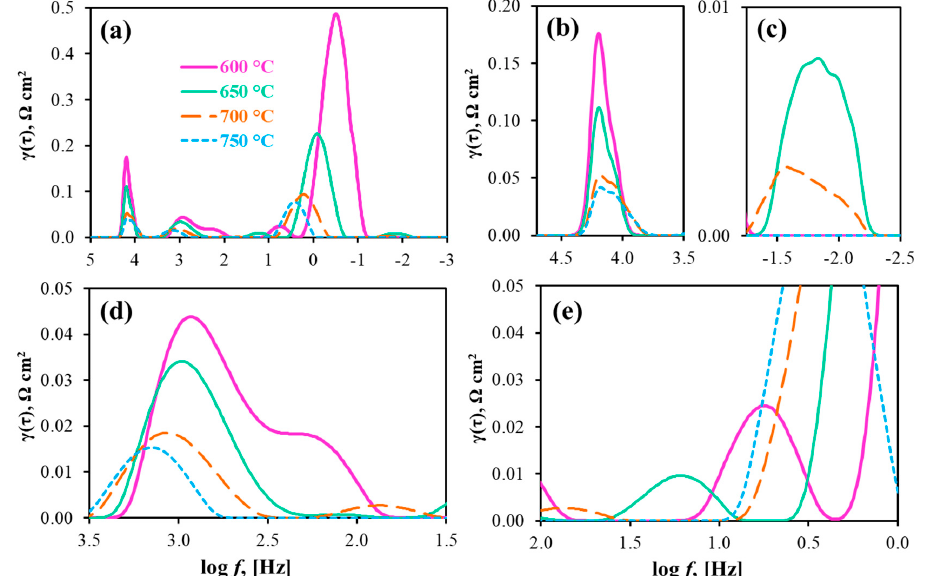
Figure 10. DRT results for the impedance spectra measured for the PCC at different temperatures under 50%H 2 O/H 2 —50%H 2 O/air and OCV conditions: general view ( a ) and its parts at different magnifications ( b – e ).